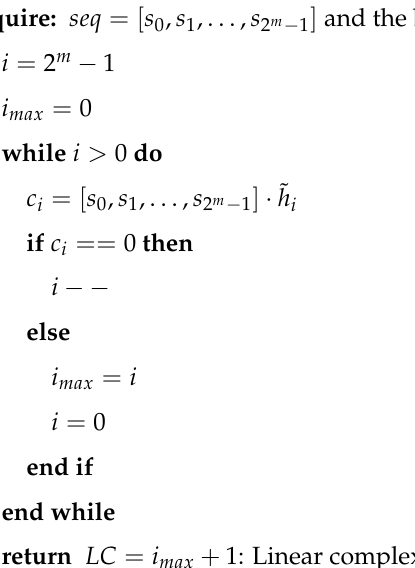
Algorithm 4 The m-BD